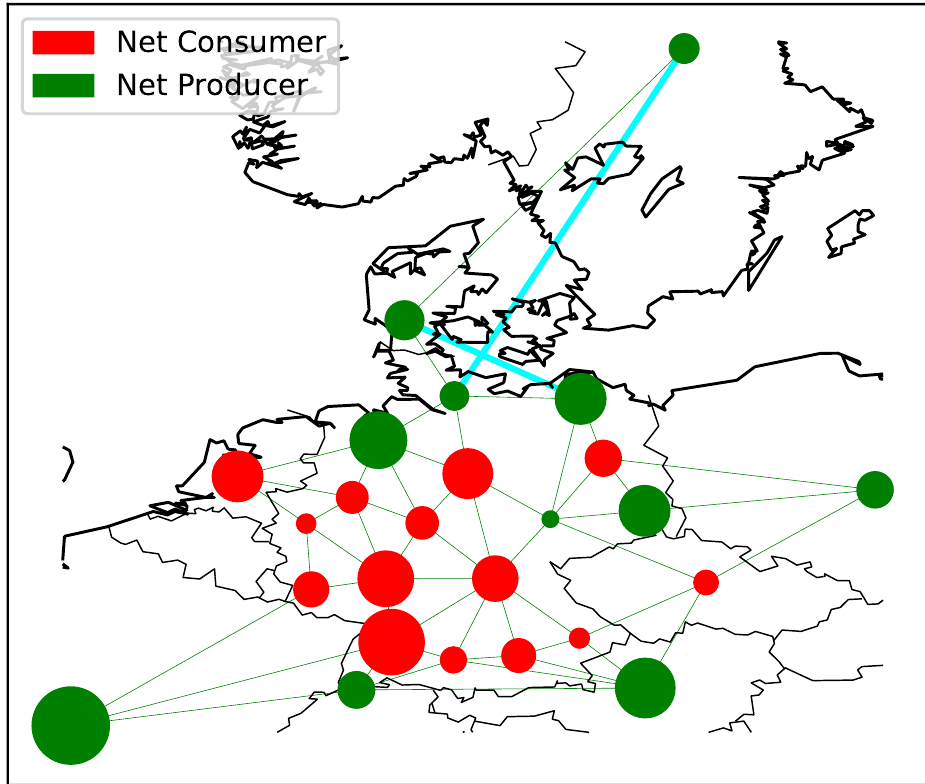
Figure 4. Annual balance of power generation and load by region. Red dots show regions with a generation deficit, green dots represent a generation surplus. Note: The full network has been clustered to 25 buses for better